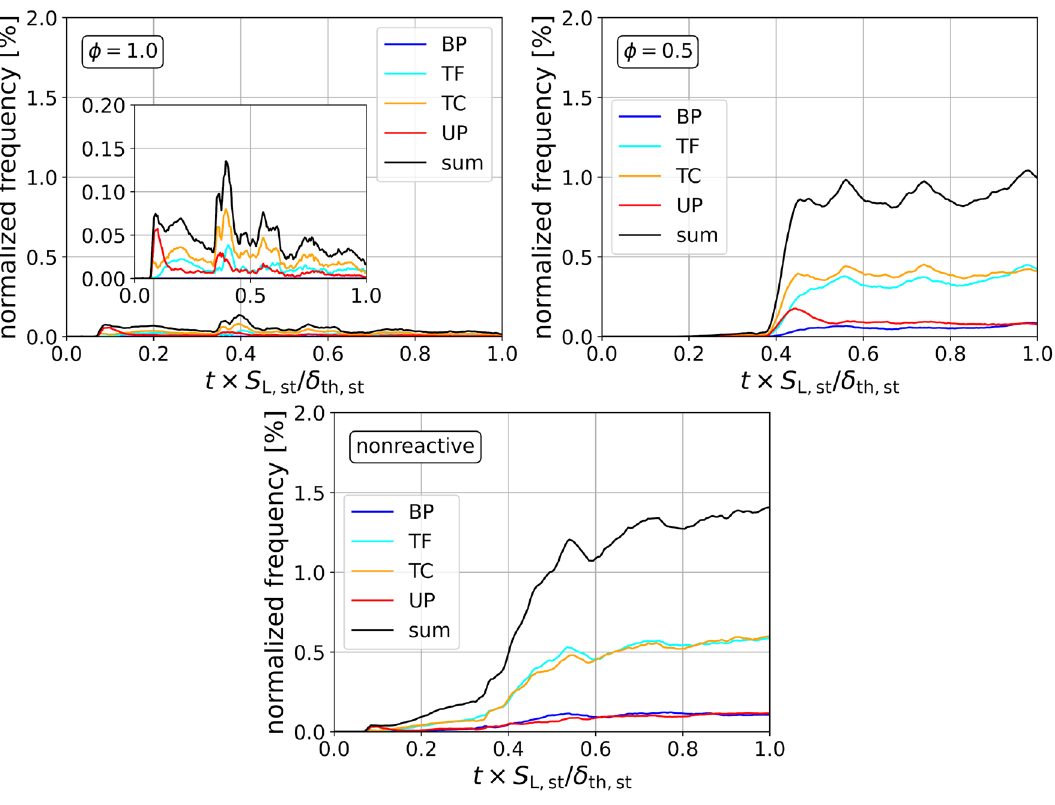
1.0 , φ 0.5 and nonreactive = =